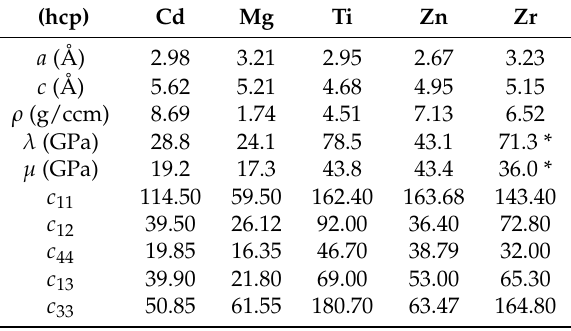
Table 2. List of input data for hcp crystals used in the calculation of the drag coefficient; all elastic constants are given in units of GPa. The references we used to compile these data are: Ref. [35] (Section 12) (lattice parameters a , c and densities ρ ), Refs. [36] (p. 10) and [37] (effective Lamé constants of the polycrystal except for Zr), Ref. [35] (Section 12) (single crystal SOEC), and Refs. [45–49] (TOEC). The Lamé constants of Zr (marked with *) are analytical averages of the single crystal SOEC (see, e.g. [34]). The conventions for the single crystal elastic constants are those of Brugger